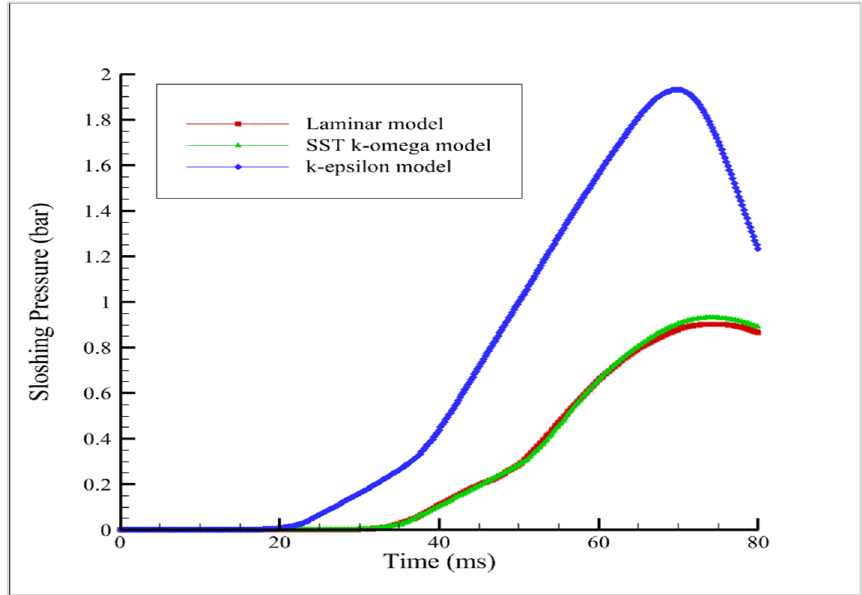
Figure 9. Comparison of viscous models effect on sloshing pressure in unbaffled rectangular tank under 25% filling